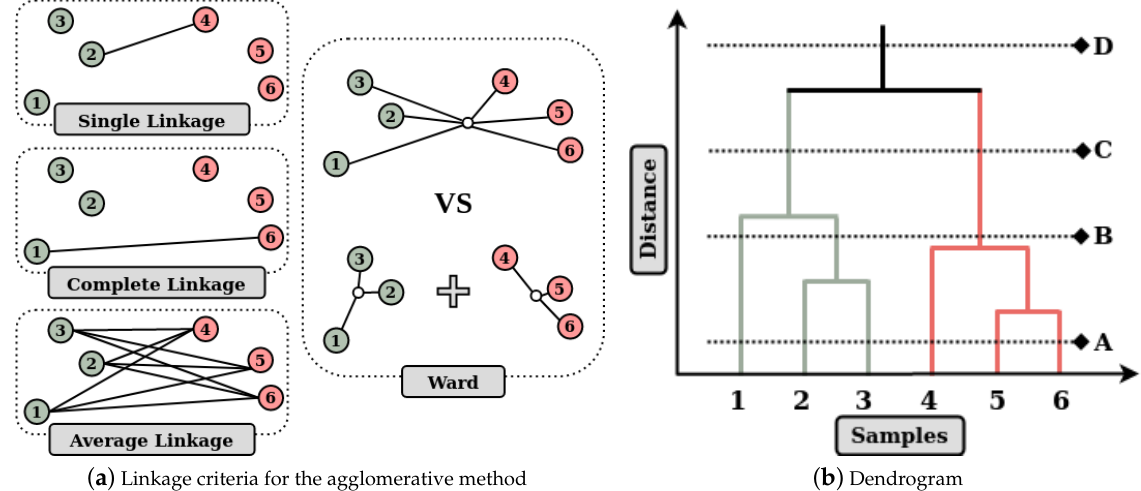
Figure 6. ( a ) Two-dimensional representation of different connection criteria for the 6 samples already allocated in two clusters. ( b ) Dendrogram resulting from the application of the hierarchical clustering algorithm on samples 1–6. The algorithm employs the agglomerative method using single bond